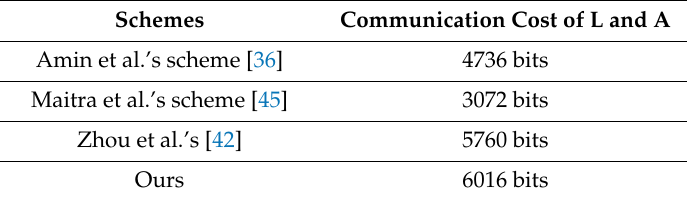
Table 3. Communication cost comparison of four authentication schemes.